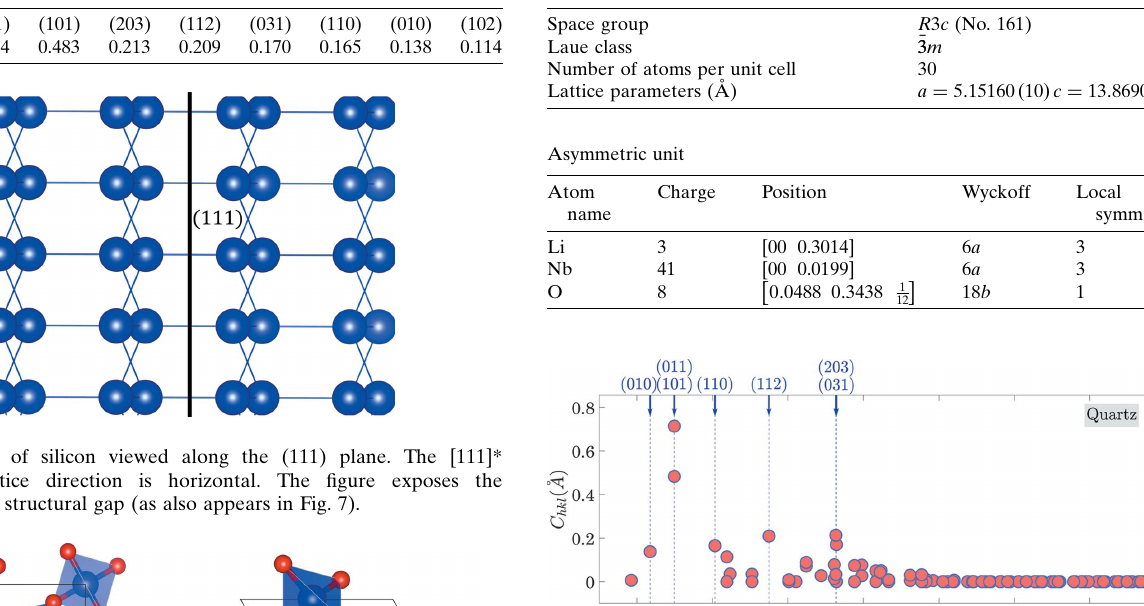
Table 6 The structure of LiNbO 3 used for the calculations (Weigel et al. ,